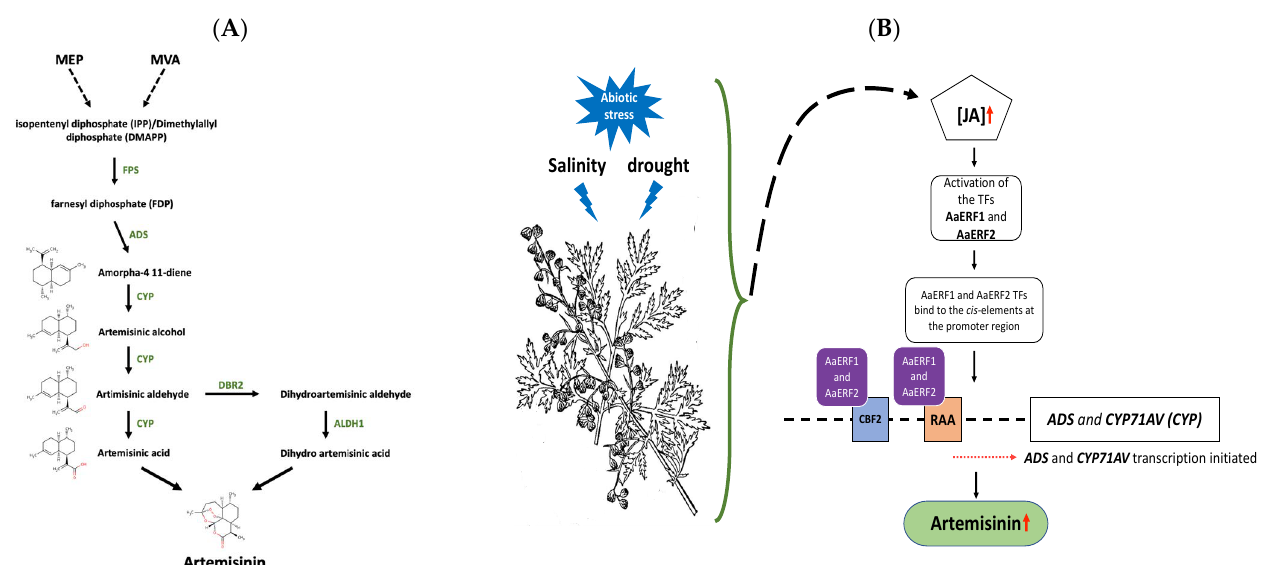
Figure 3. ( A ) The artemisinin biosynthetic pathway. ( B ) Jasmonic acid elicitation of artemisinin in the plant Artemisia annua . JA content is increased when the plant Artemisia annua is exposed to salinity or drought stresses. The increased JA level leads to the activation of two AP2/ERF transcription factors (AaERF1 and AaERF2) that bind to the CBF2 and RAA cis -acting elements that are found on the promoter regions of the ADS and CYP genes that are major components of the artemisinin biosynthesis pathway.